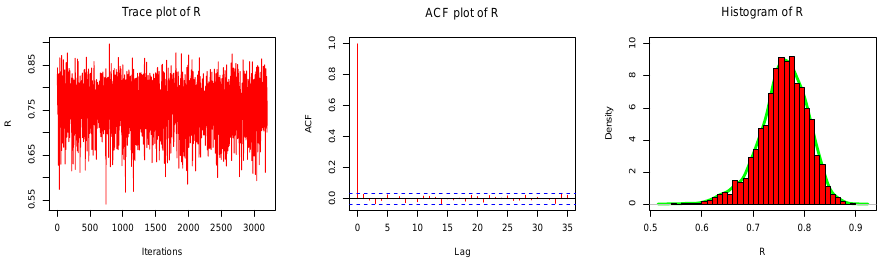
Figure 5 – The trace, ACF and histogram with Gaussian density plots of the generated chain for parameter R corresponding to censoring scheme ( CS